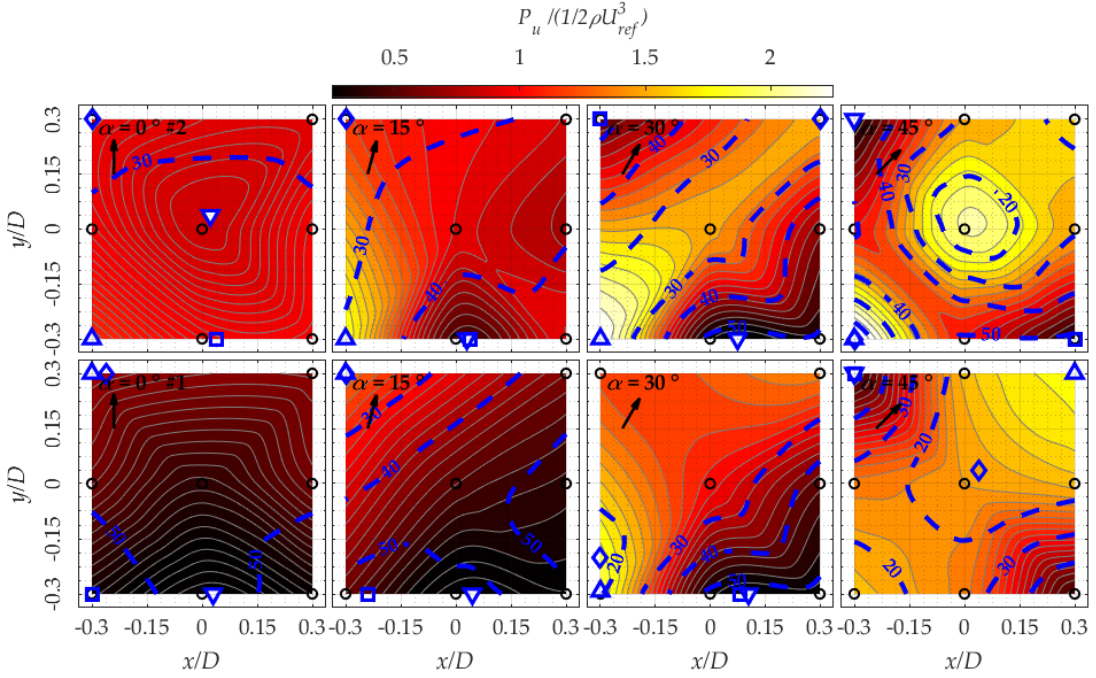
Figure 18. Wind Power density normalised against reference velocity, for configurations #1 (bottom row) and #2 (top row) and height z/D = 0.1 equivalent to 3 m in full scale. and indicate, respectively, the position of the lower and higher wind power density. Dashed blue contour lines show turbulence intensity I u (%), with markers and , respectively, showing the position of lower and higher I u .